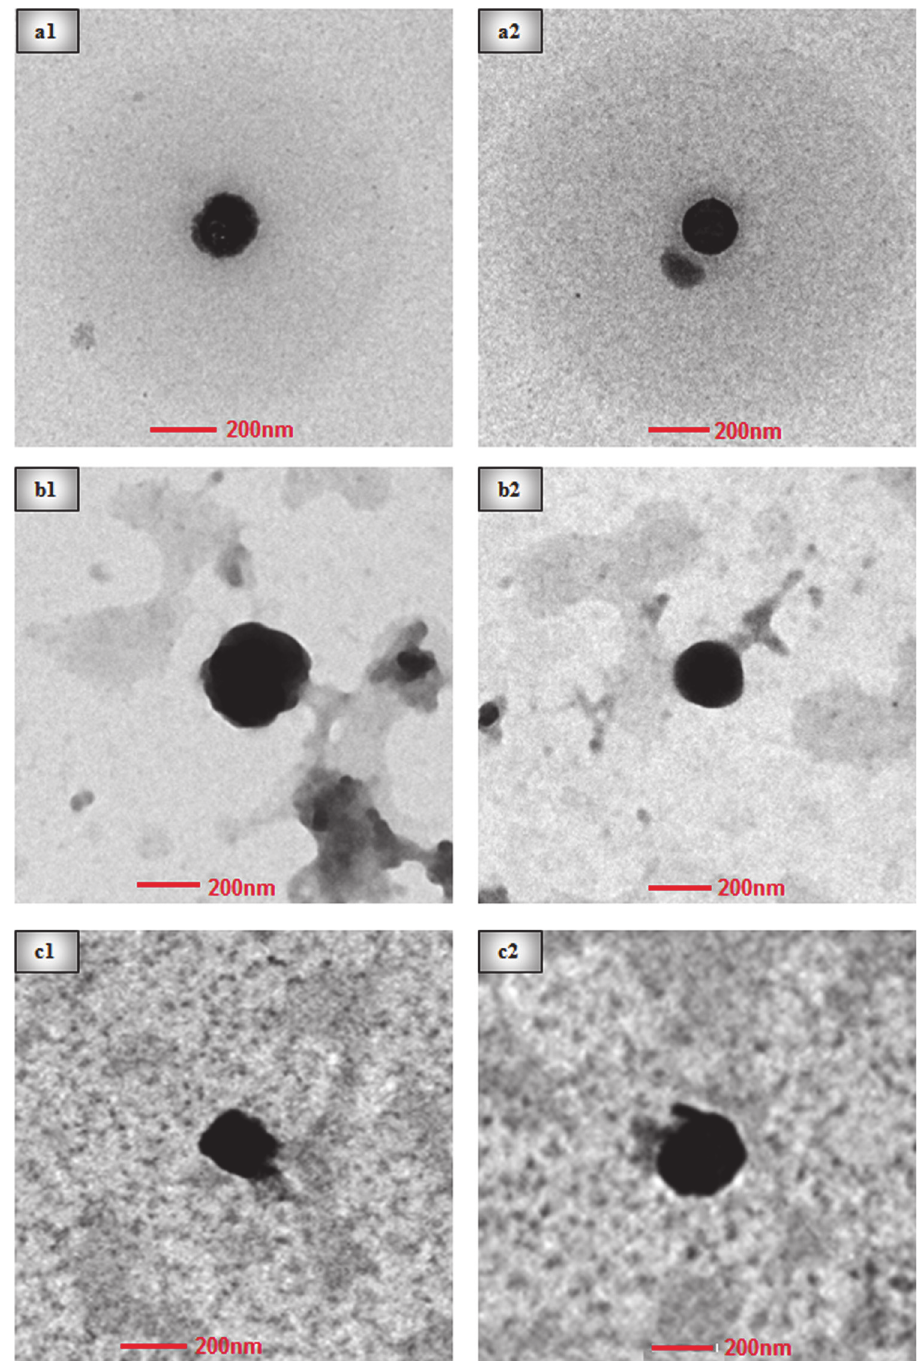
Fig 7. TEM images of chitosan derivatives nanoparticles. Figure showing transmission electron micrographs(a1, a2), (b1, b2), and (c1, c2) represents CSNP3, CSNP4, and CSNP5